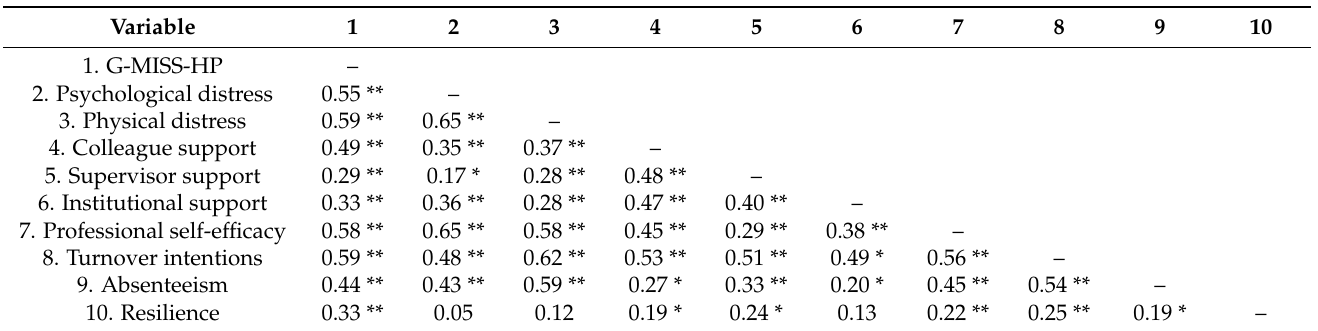
Table 8. Pearson’s correlations between G-MISS-HP Score and G-SVESTR